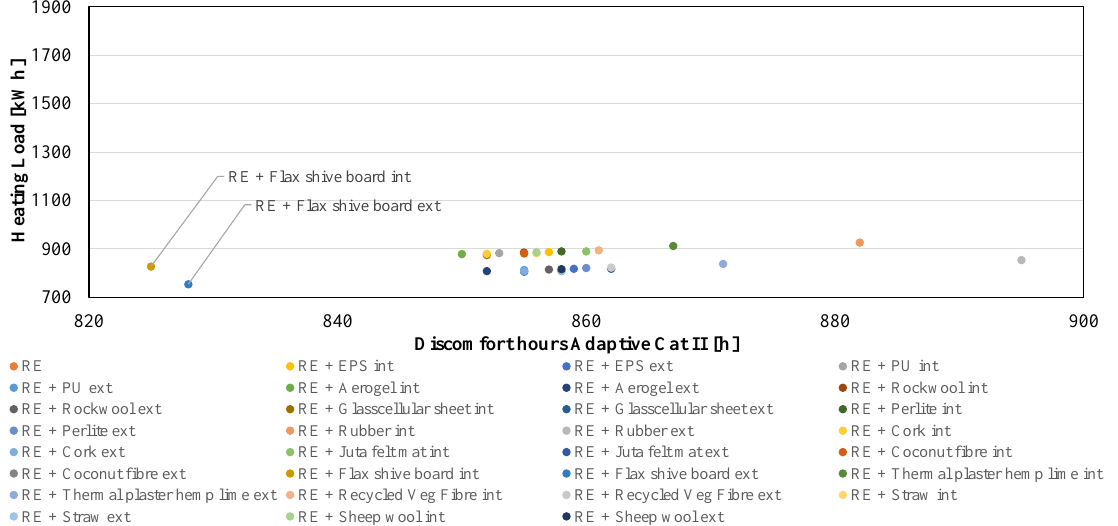
Figure 8. Heating loads vs. total building cost ( a ), embodied carbon ( b ), and discomfort hours as for category II of adaptive comfort model ( c ). Optimised rammed earth (RE) insulated wall constructions indicated with